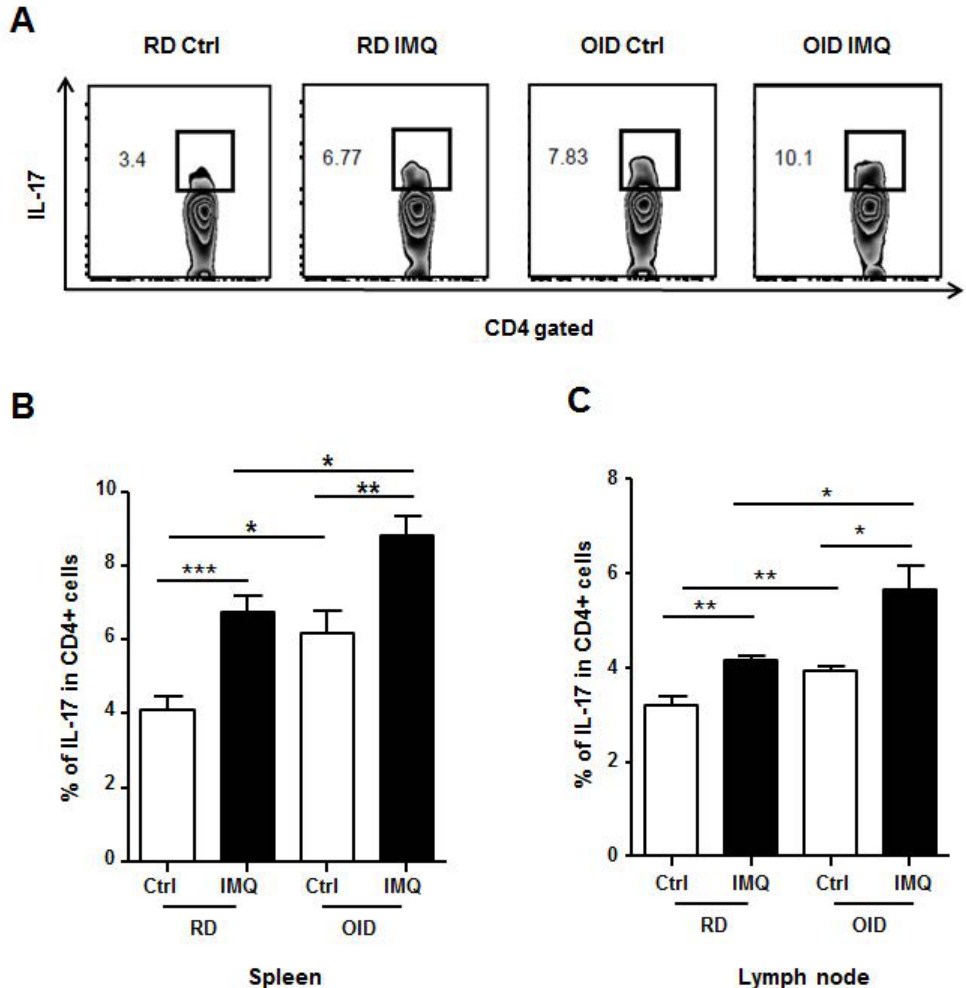
Figure 3. The population of IL-17-producing Th17 cells in the spleens and draining lymph nodes in imiquimod (IMQ)-treated mice reared on an obesity-inducing diet (OID) or regular diet (RD) ( n = 4–6/group), seven days after imiquimod treatment. Single cells were isolated from spleens and lymph nodes, labeled with conjugated antibodies specific for CD3, CD4, and IL-17, and then analyzed by flow cytometry. ( A ) Gating used, ( B ) Spleen, ( C ) Lymph node. Data are rep- resented as means ± SEM. * p < 0.05, ** p < 0.01, and *** p < 0.001. Results are representative of two independently performed